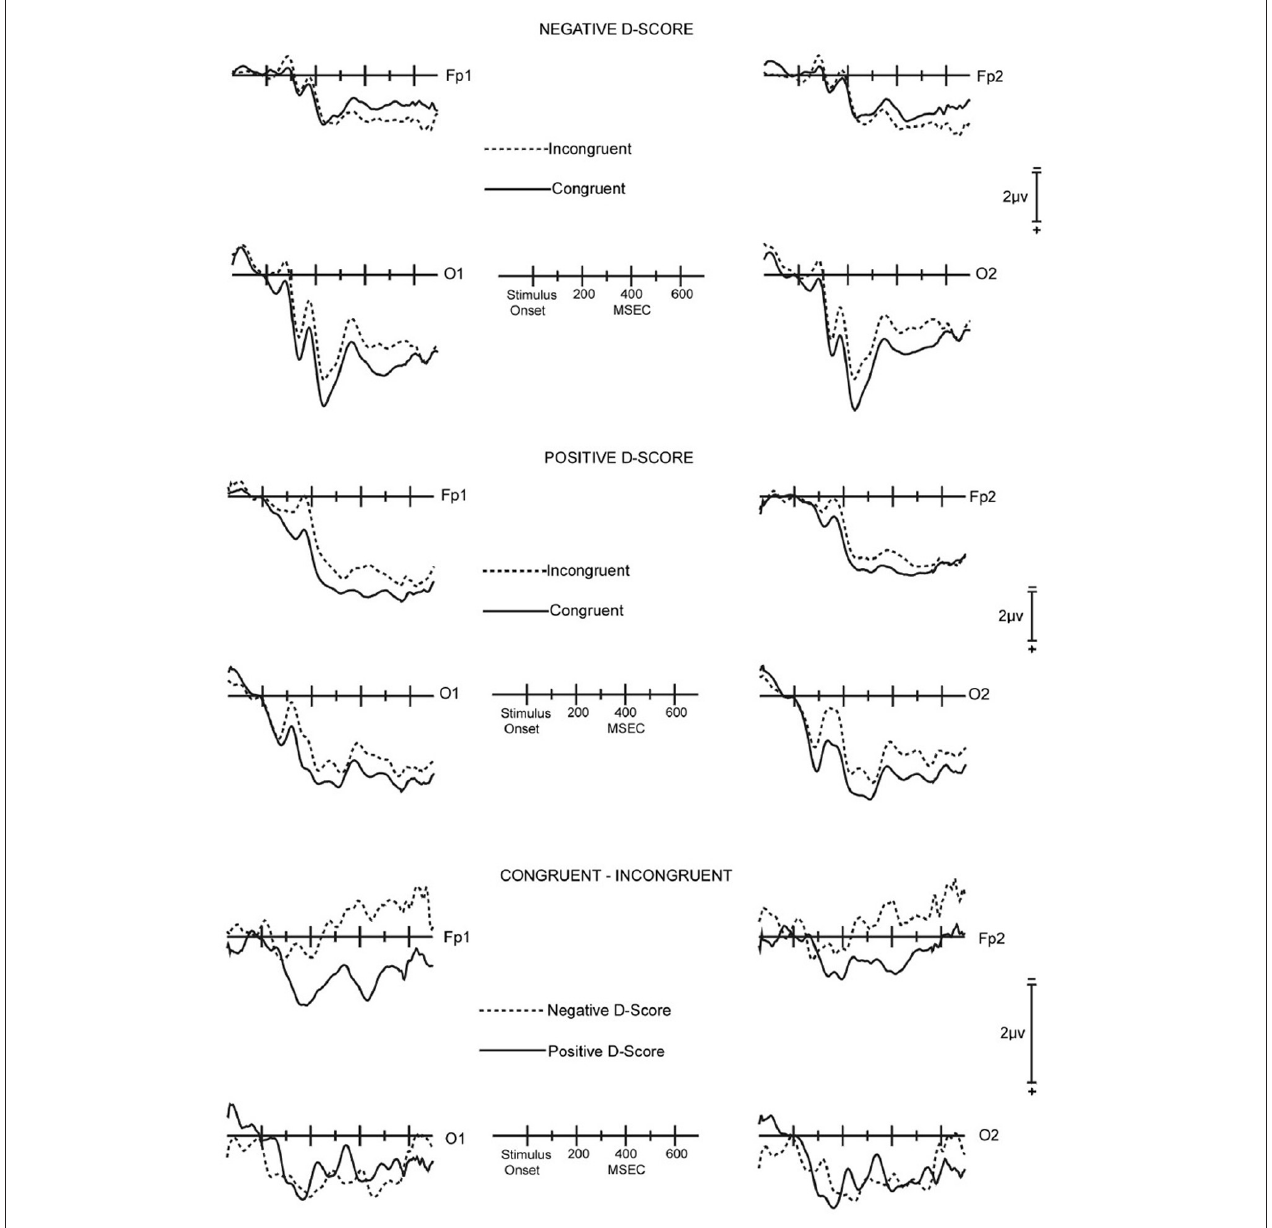
FIGURE 2 | Across-subjects averaged unsubtracted and difference ERP waveforms for the ROI. Top panel: Averaged unsubtracted ERPs for the seven subjects with negative IAT scores for congruent (solid lines) and incongruent (dashed lines) stimuli. Middle panel: Averaged unsubtracted ERPs for the seven subjects with positive IAT scores